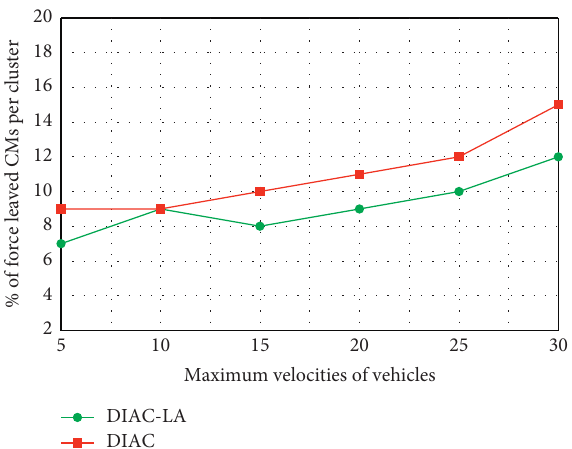
Figure 7: Percentage of vehicles that forcefully leave per cluster at various velocities of vehicles.